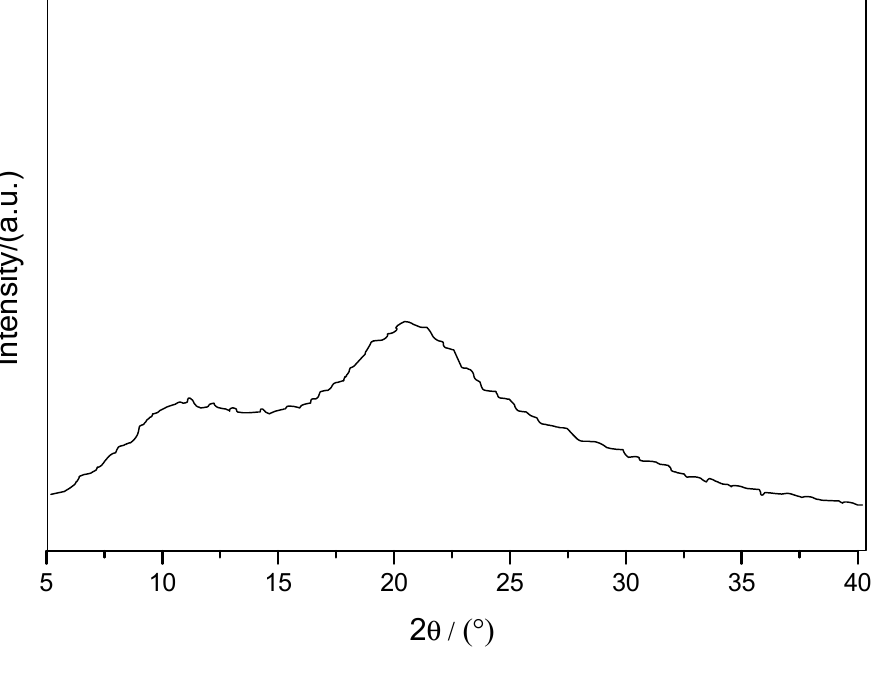
Figure 9. PXRD spectra of PVP.